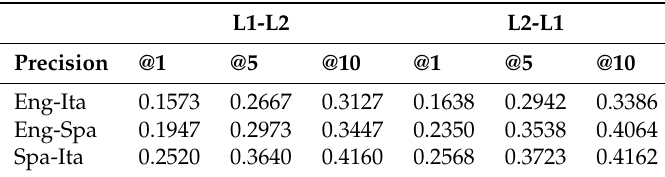
Table 13. Bilingual results of the multilingual model trained using three different languages at the same time.